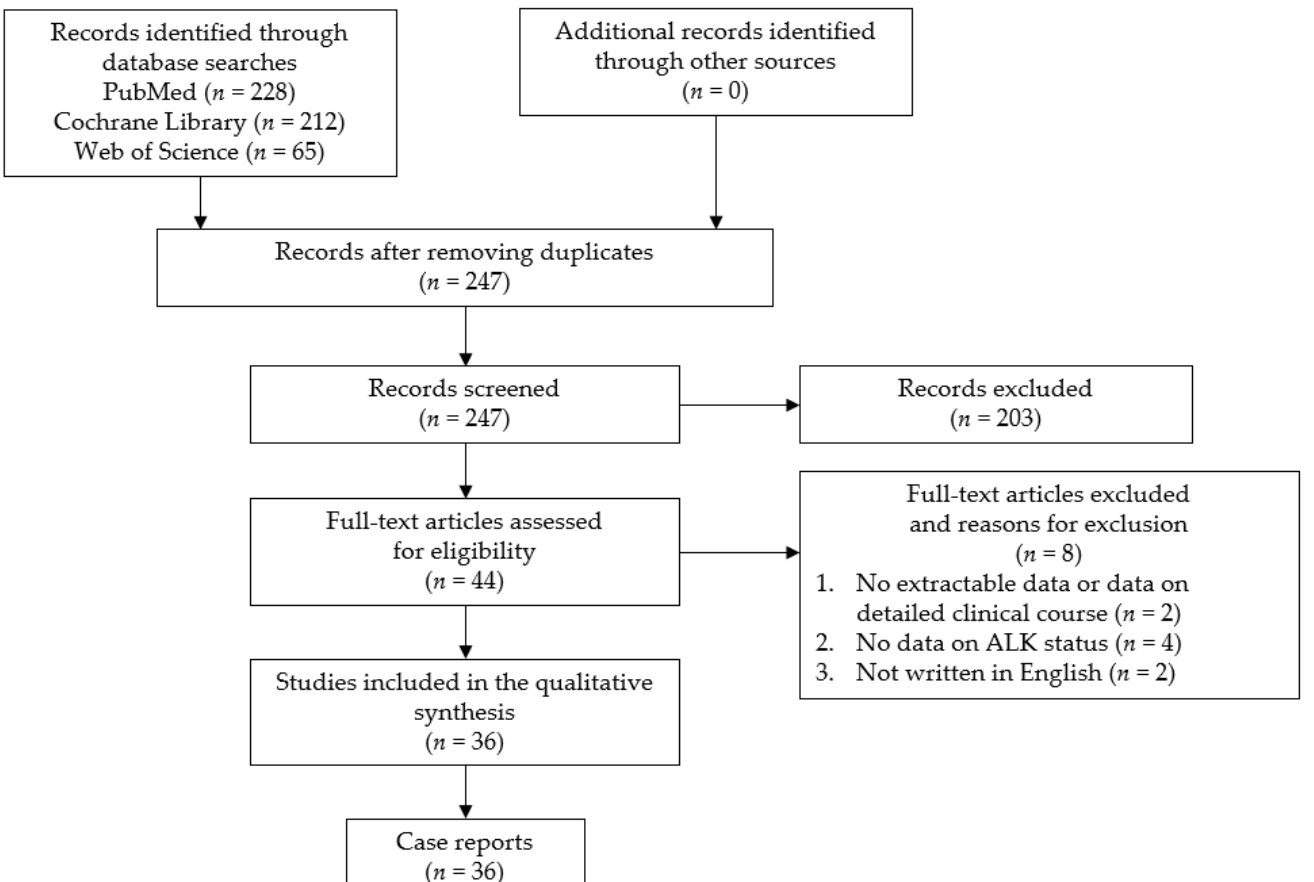
Figure 1. Flow chart of the study selection process. ALK: anaplastic lymphoma kinase.